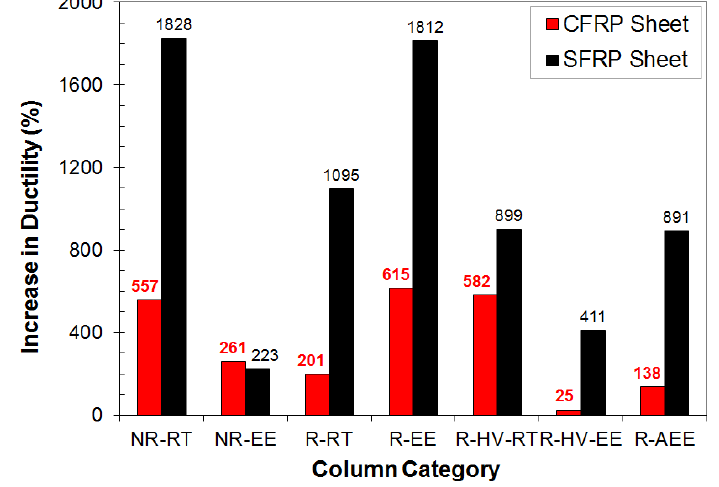
Figure 5. Percentage increase in the ductility of the SFRP and CFRP wrapped concrete